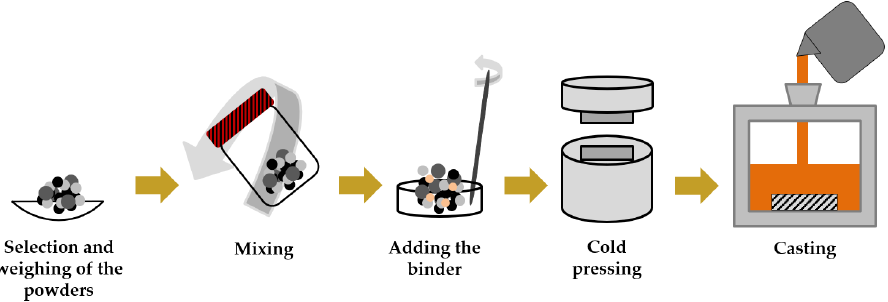
Figure 1. Scheme of the fabrication steps for the production of a reinforced part (adapted from [64]).